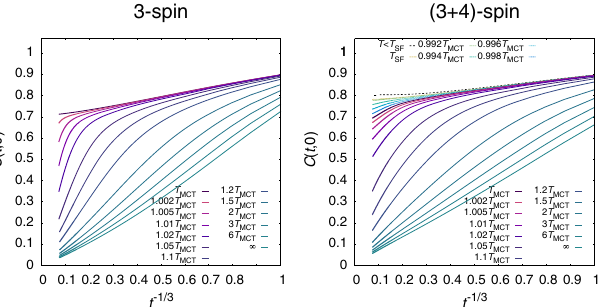
FIG. 31. Decay of the correlation with the initial configuration C ð t; 0 Þ vs t − 1 = 3 in the three-spin model (upper panel) and the ( 3 þ 4 )-spin model (lower panel). Our choice of using the t − 1 = 3 variable is to make the relaxation from T ¼ ∞ as linear as possible [notice, however, that the exact value for the decay exponent of C ð t; 0 Þ is unknown even in this case]. While data for − μ ð t Þ , varying t , FIG. 29. Parametric plot of E ð t Þ versus μ the three-spin model can be easily extrapolated to zero in the mg which allows for more reliable extrapolations. The dotted lines large-time limit, the data for the ( 3 þ 4 )-spin model seem much − are the best power-law fits in the form E ¼ E ∞ ð T Þ þ A ð T Þð μ more compatible with a nonzero limit q 12 ¼ lim t → ∞ C ð t; 0 Þ when mg μ Þ α ð T Þ used to estimate the asymptotic the temperature gets close to T MCT